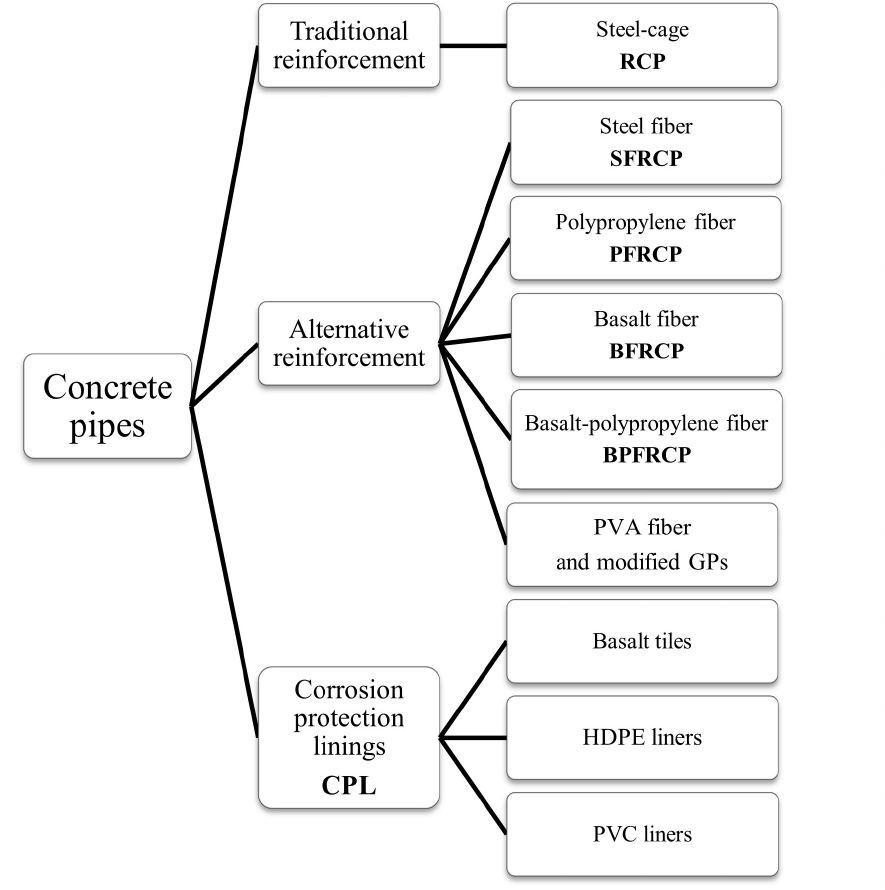
Figure 8: Types of modern concrete